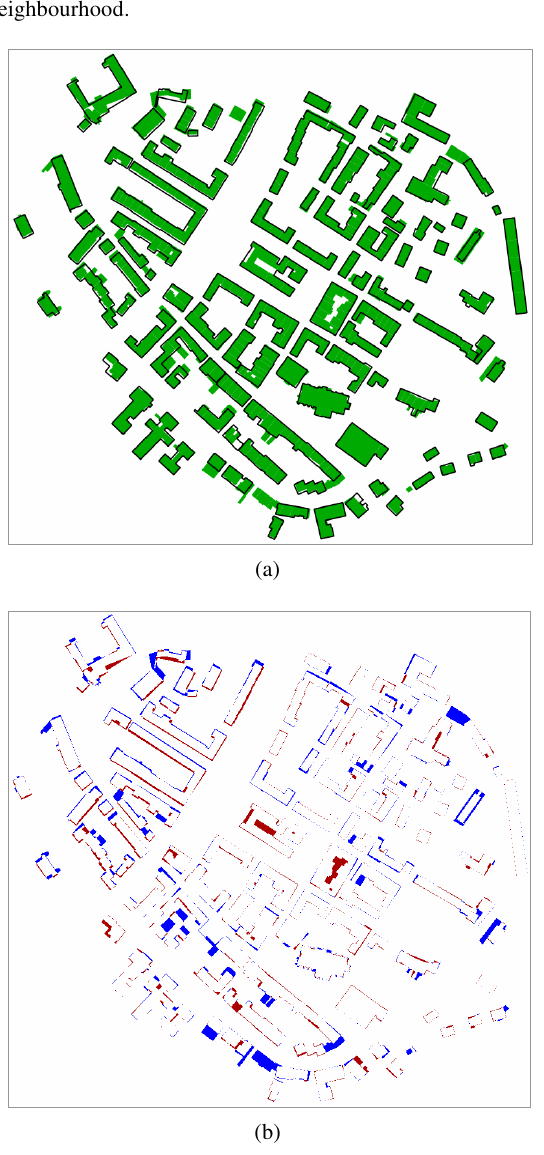
Figure 3. Comparison with a reference data, (a) building footprints from cadastre (green) and reconstructed building outlines (black); (b) omission errors (blue) and commission errors